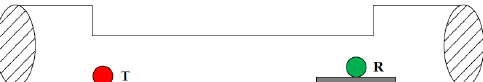
Figure 2. Experimental model diagram.